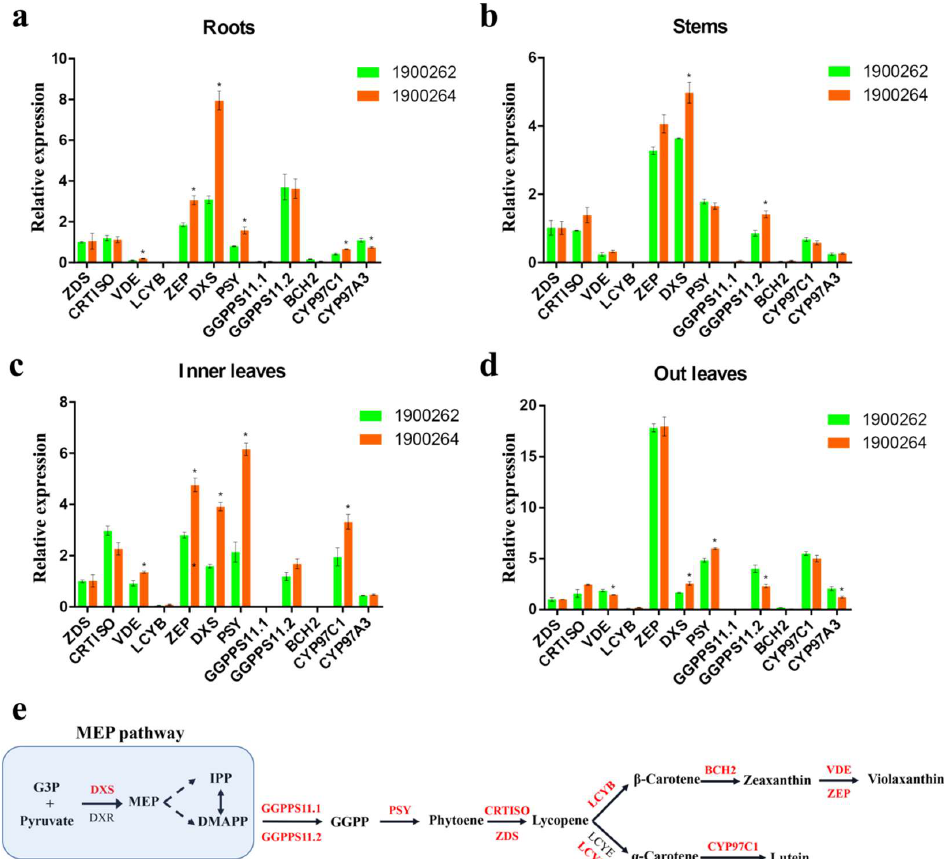
Figure 7. Expression of carotenoid biosynthetic genes in lines ‘1900262′ and ‘1900264′. Relative expression levels of carotenoid−synthesis−related genes in the roots ( a ), short stems ( b ), inner leaves ( c ), and outer leaves ( d ) of lines ‘1900262′ and ‘1900264′. ZDS , BraA05g040310.3C ; CRTISO , BraA09g063710.3C ; VDE , BraA06g005700.3C ; LCYB , BraA03g017230.3C ; ZEP , BraA07g016880.3C and BraA07g016890.3C ; DXS , BraA01g021140.3C ; PSY, BraA02g006890.3C ; GGPPS11.1 , BraA08g021280.3C ; GGPPS11.2 , BraA01g002000.3C ; BCH2 , BraA10g010930.3C ; CYP97C1 , BraA07g021850.3.5C ; CYP97A3 , BraA08g009810.3C . An asterisk (*) indicates that there is a statistical difference, p ≤ 0.05, n = 3. Bractin served as a control. ( e ) Outline of the carotenoid biosynthetic pathway. Red words indicate genes validated in the